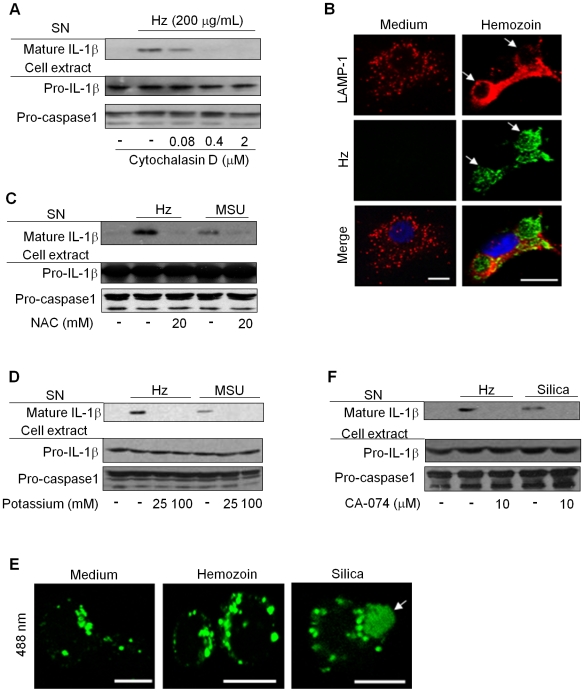
Hemozoin-induced IL-1β production is dependent on phagocytosis, reactive oxygen species (ROS) generation, potassium efflux and cathepsin B.PMA-differentiated THP-1 cells (0.75×106 cells/0.5 mL) were stimulated with Hz (200 µg/mL) or MSU (100 µg/mL) and exposed to the indicated concentrations of (A) phagocytosis inhibitor cytochalasin D, (C) the ROS-scavenger N-acetyl cysteine (NAC), (D) extracellular potassium or, (F) the cathepsin B inhibitor CA-074. After six hours of incubation, supernatant (SN) and cell extracts were collected and subjected to Western blot analysis with the indicated antibodies. (B) BMDM were incubated or not with 200 µg/mL Hz (green) and stained for LAMP-1 (red) and for nucleus with DRAQ5 (blue). (E) PMA-differentiated THP-1 cells were stimulated or not with Hz (200 µg/mL) or silica (400 µg/mL) in the presence of DQ-OVA (10 µg/mL) for 30 minutes, washed and further incubated for three more hours. Green fluorescence represents cleaved OVA. Data shown are images obtained by confocal microscopy from one representative experiment of three independent experiments. Scale bars = 5 µm.